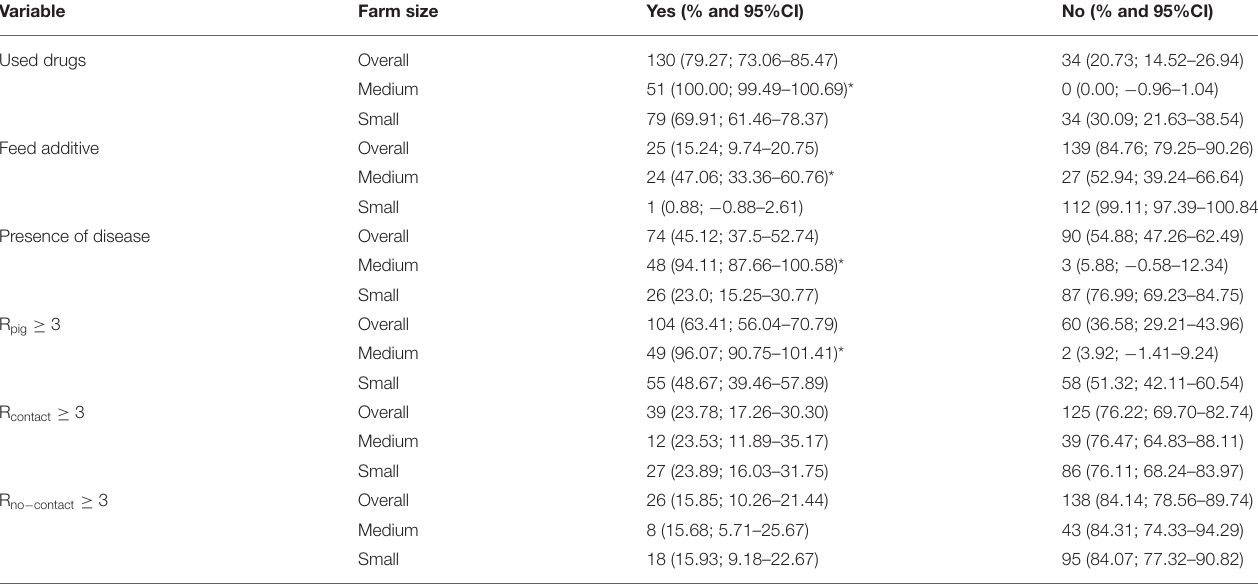
TABLE 1 | Number of farms, percentage, and 95% confidence interval (CI) from data collected from 164 farms (51 medium-scale farms and 113 small-scale farms) in Khon-Kaen, Thailand.